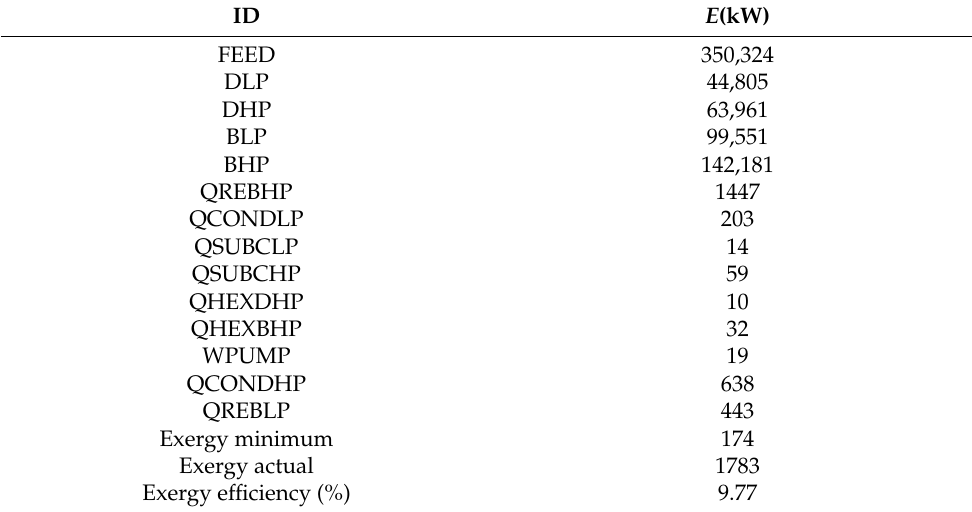
Table 5. Exergy analysis of the EHIDDiC system.